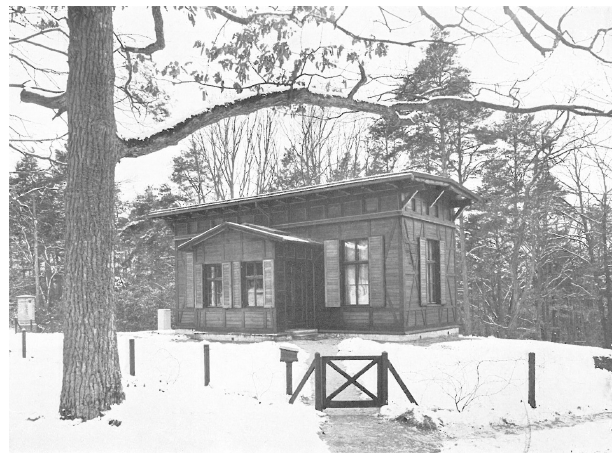
Figure 3. View of the absolute house from the north-east. Source: Hellmann